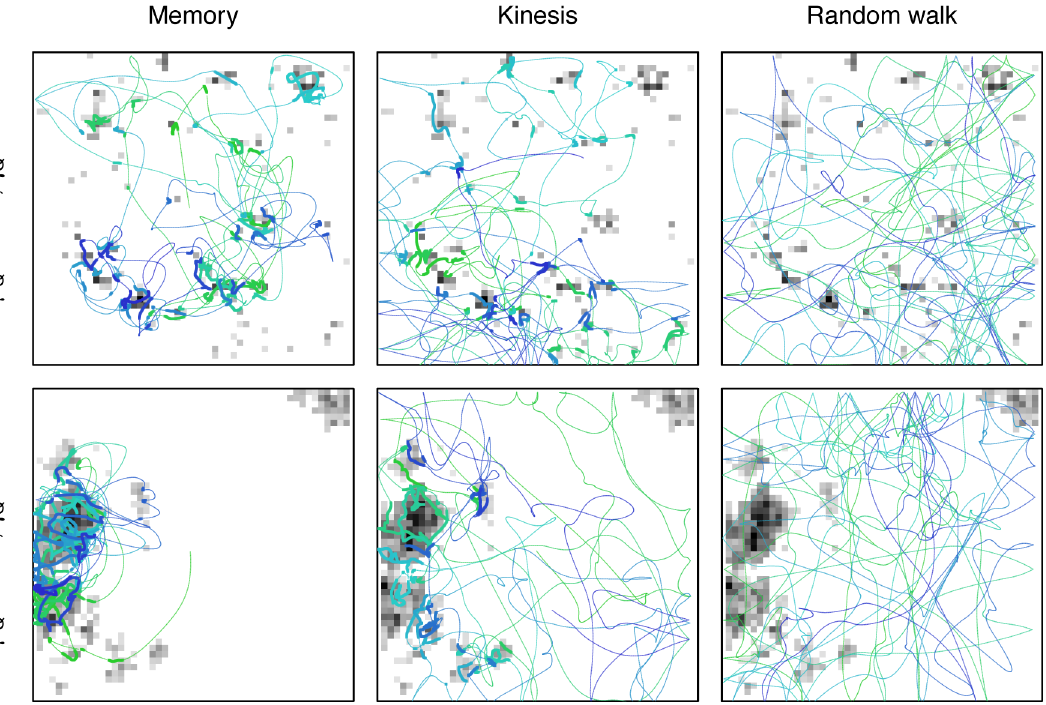
Fig 2. Sample trajectories for three movement models (left to right) on two different landscapes (top to bottom). Trajectories start at the center with color changing through time (from green to light blue to dark blue). For memory and kinesis, thin lines indicate searching and thick lines indicate feeding behavior. Resources are shown at their undepleted level at the beginning of the simulation. Memory is parameterized with best overall parameters, ϕ L = 1 e ψ γ − 05, ϕ S = 0.01, M = 2, Z = 10.